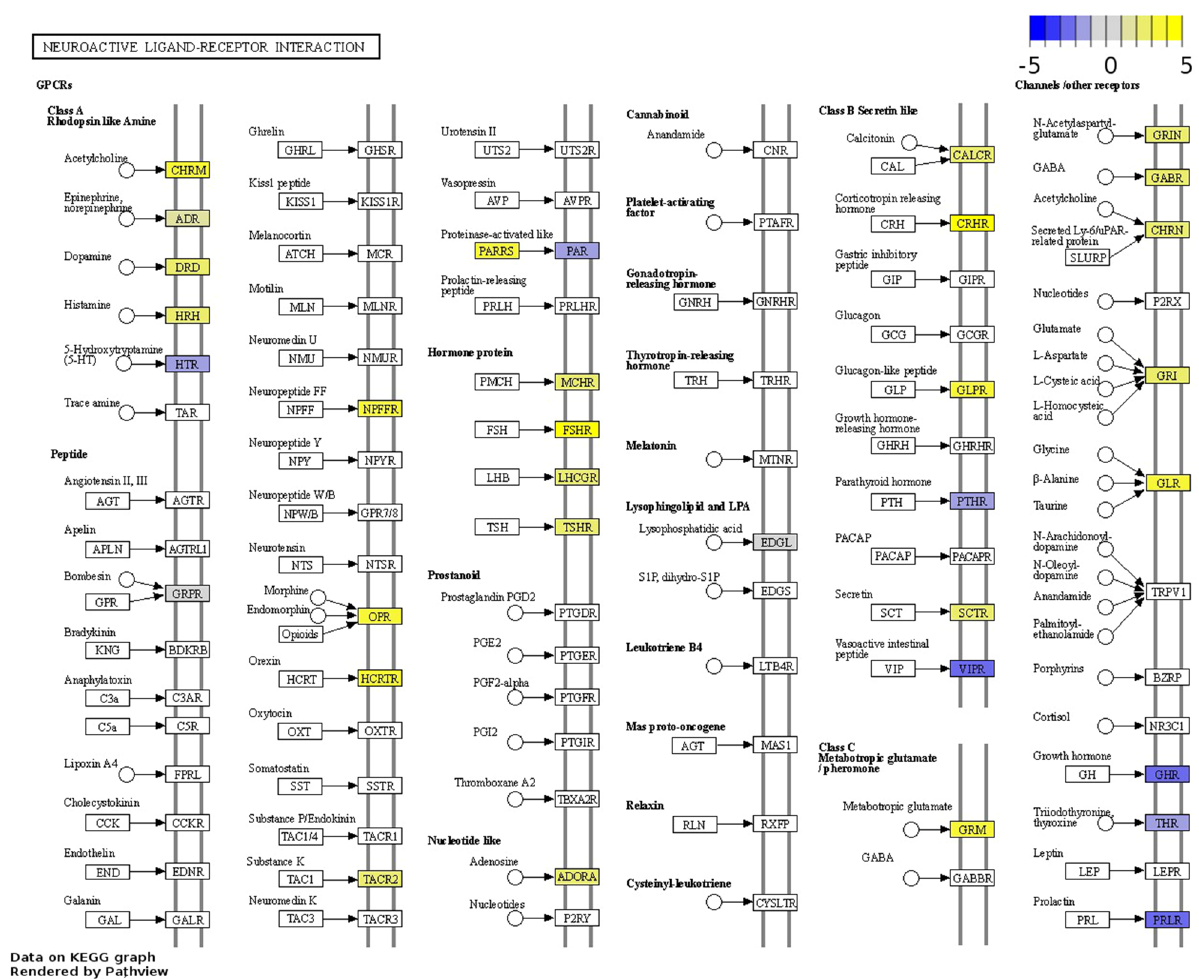
Figure 5. DEGs enriching the Neuroactive Ligand-Receptor Interaction pathway (fca04080) in normal-like triple-negative tumours. Gene log 2 fold change relative to controls is indicated in yellow (upregulated) or blue (downregulated), white boxes represent genes not detected. Data on KEGG graph rendered by “Pathview” (https:// pathv iew. uncc.